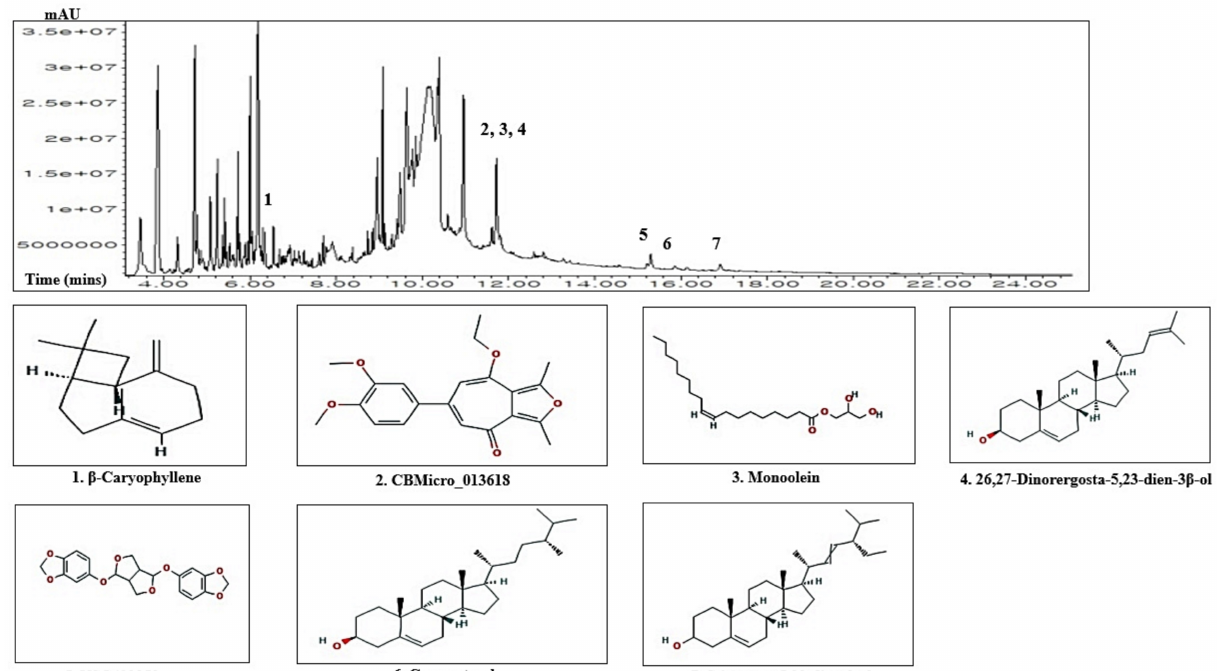
Figure 2. A typical GC-MS peak of ZPFs methanolic extract and the number of seven key